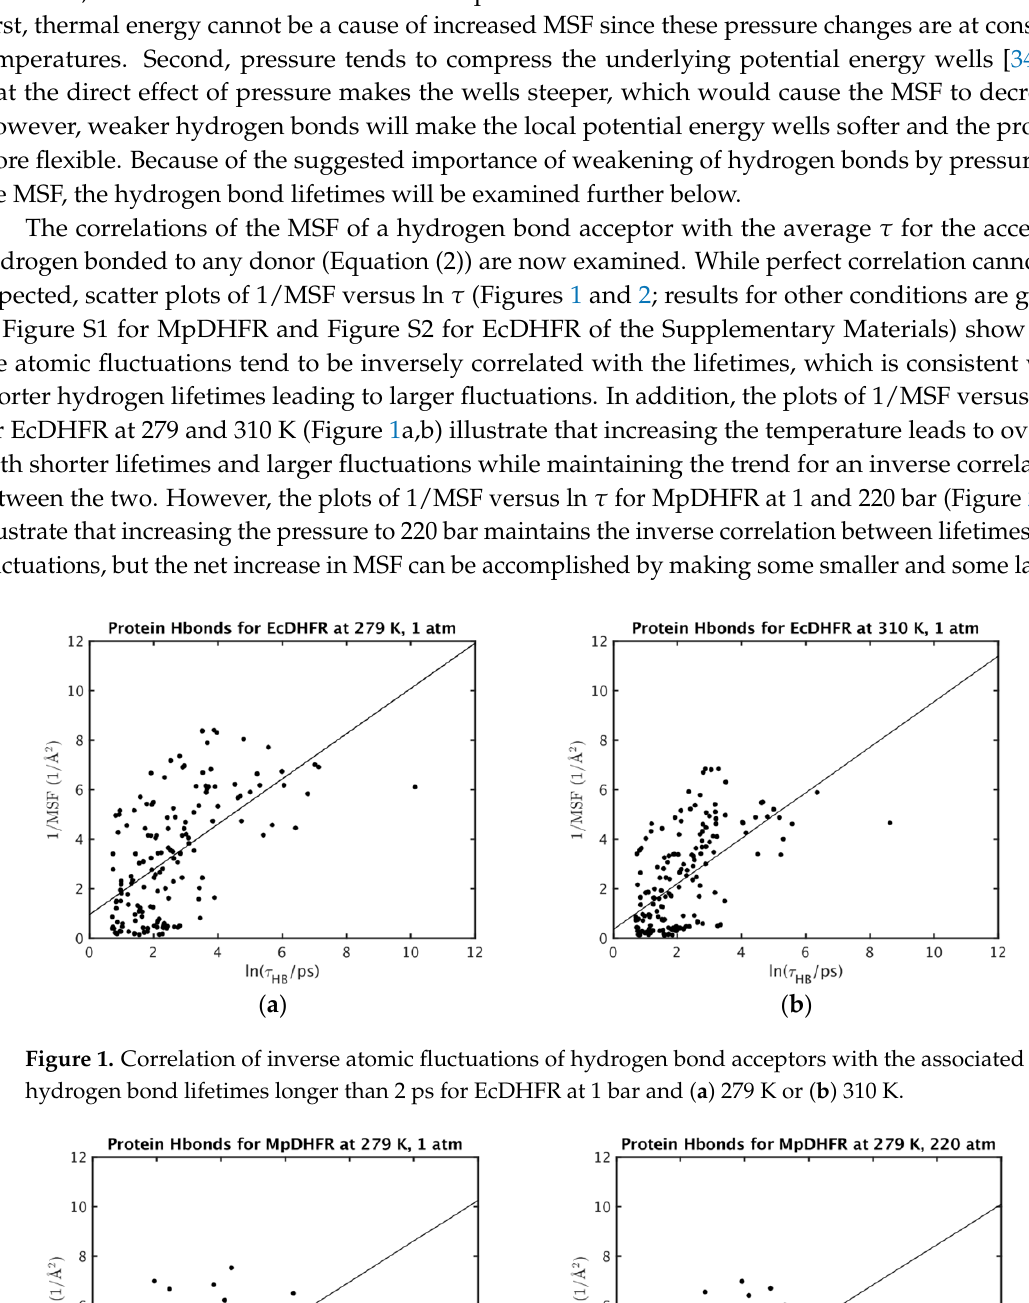
Table 3. Changes of average properties for EcDHFR and MpDHFR with pressure at constant temperature T , where Δ P indicates a change from 1 to 220 bar and percentages are with respect to the 1 bar value. Note that MpDHFR is close to its melting temperature at 310 K.